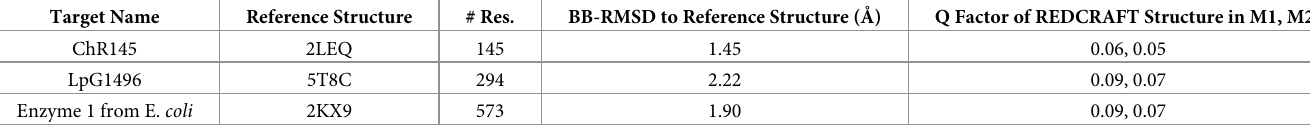
Table 3. Structure determinations of larger proteins by REDCRAFT using synthetic RDCs. Target Name